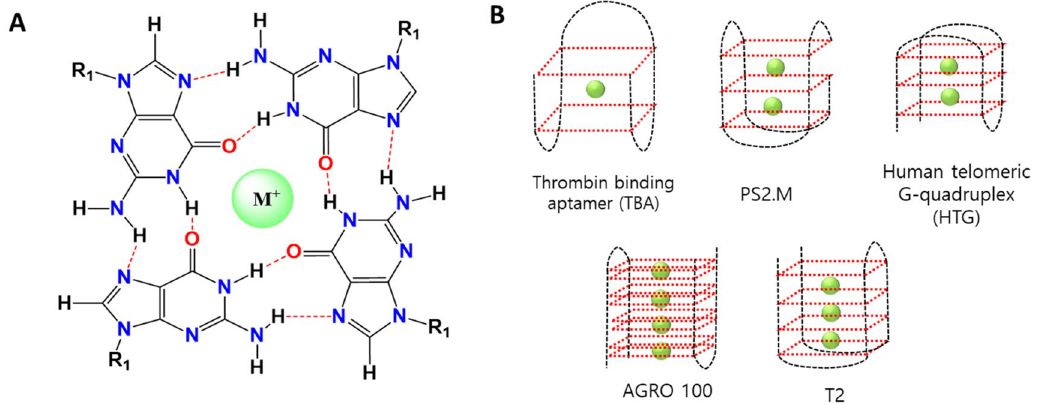
Figure 1. Guanine-rich quadruplex structures (G-QDs) investigated in this study. ( A ) Chemical structure of G-QDs involved with a metal ion. ( B ) Schematic design of G-QDs for five types of nucleotides. Green circles represent metal ions, such as K + , Na + , or Pb 2+